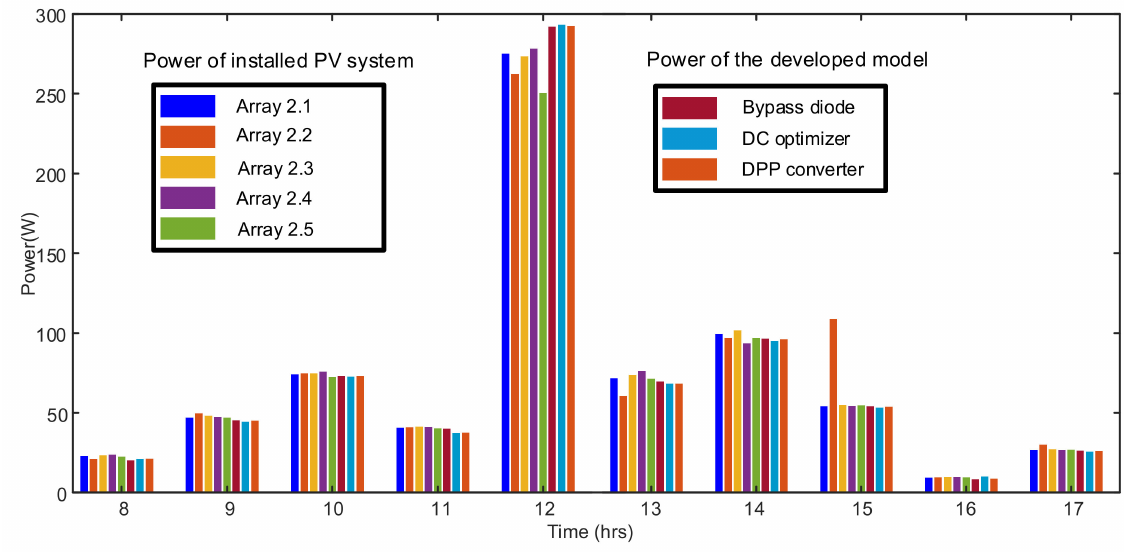
Figure 16. PV system outputs over a day under irradiance data on 8th June shown in Figure